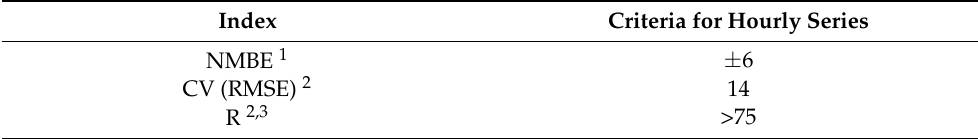
Table 1. Statistical criteria for calibration were applied in the